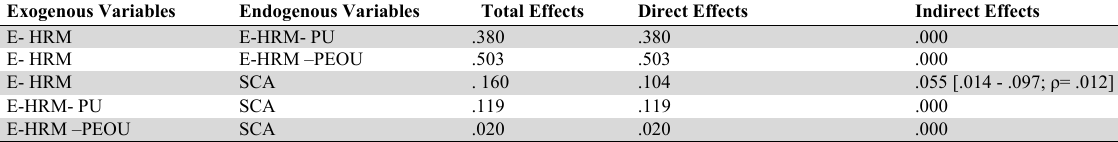
Mediation affects sizes for the study model.